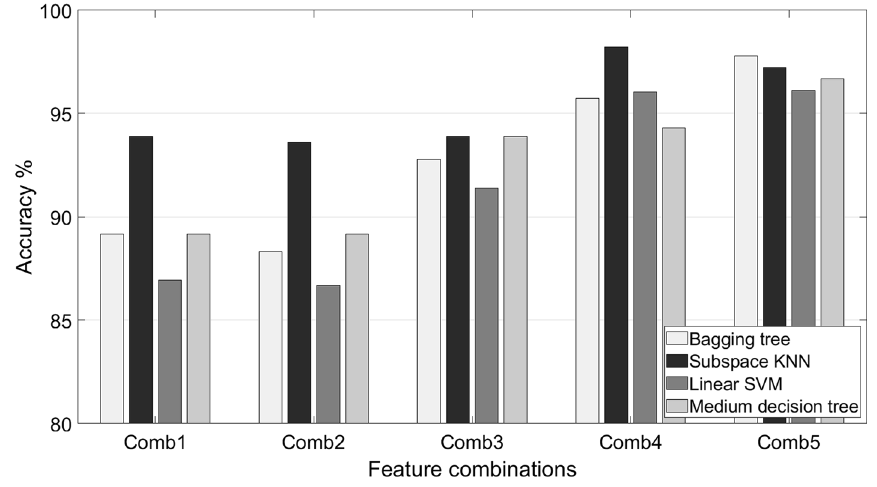
Fig. 16 Impact of the features